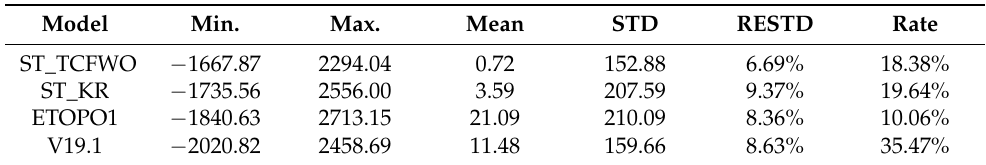
Figure 10. Local seafloor topographic model, namely, the part intercepted from Figure 8, in which the shipborne control points are relatively sparse. ST_TCFWO model, ST_KR model, ETOPO1 model and V19.1 model are shown from left to right. The red dots are the check points with relative accuracy greater than 8.26%. The number of dots in each model is 228, 357, 399 and 106, respectively. The yellow box area was used to analyze the model accuracy under different sea areas. Table 7. The results of the difference between the local model and the shipborne survey check points. (unit: